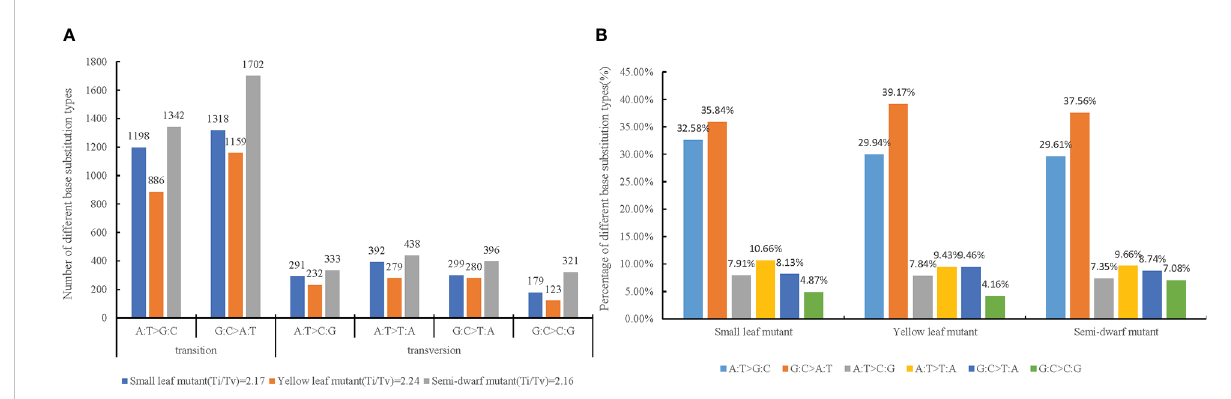
FIGURE 2 Transitions and transversions of induced by CIB irradiation among three mutation lines. A:T>G:C and G:C>A:T are transitions(Ti), A:T>C:G, A:T>T:A, G:C>T:A and G:C>C:G are transversions(Tv). (A) Number of different base substitution types and ratio of Ti/Tv in three mutation. (B) Percentage of different base substitution types in each mutation line.